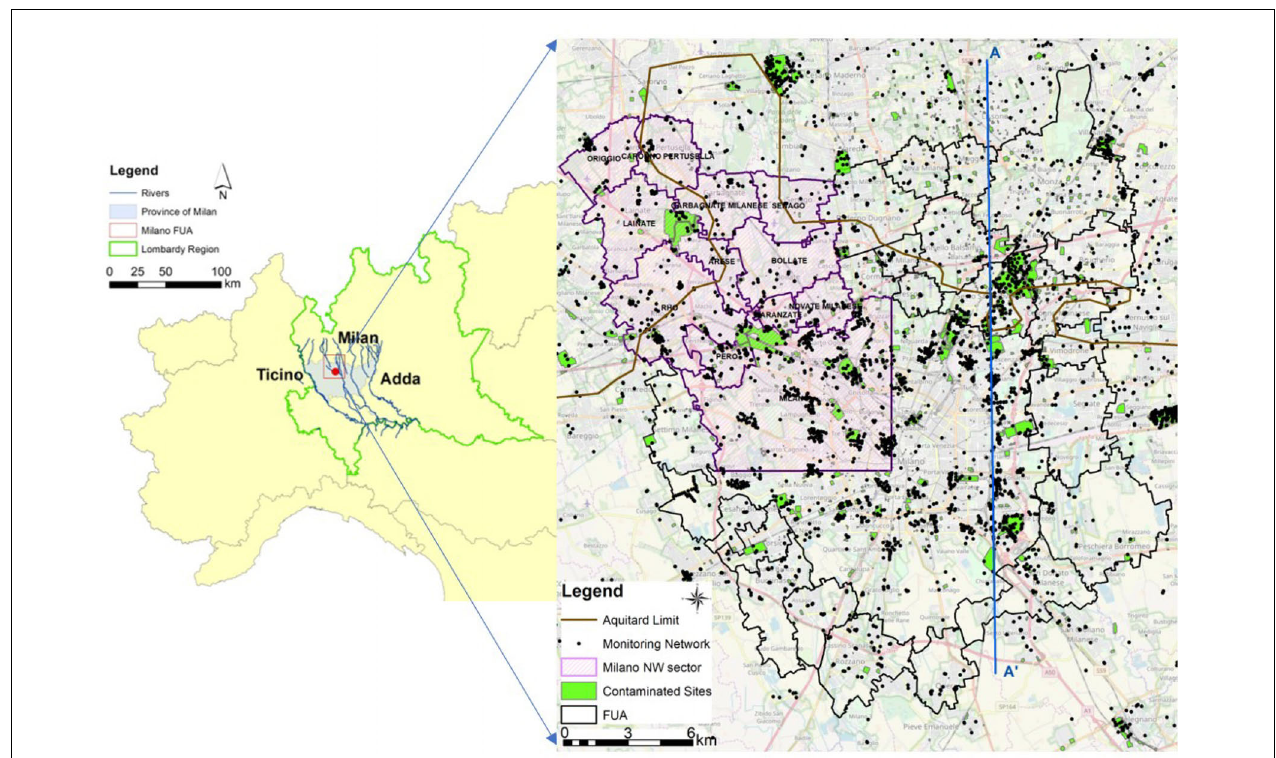
FIGURE 1 | Study area and distribution of available monitoring network and contaminated sites. The pilot area in the right is colored by pink (12 municipalities: Milano, Pero, Rho, Baranzate, Novate M.se, Bollate, Arese, Senago, Garbagnate M.se, Lainate, Caronno Pertusella and Origgio). The Milano Province on the left is dashed with gray